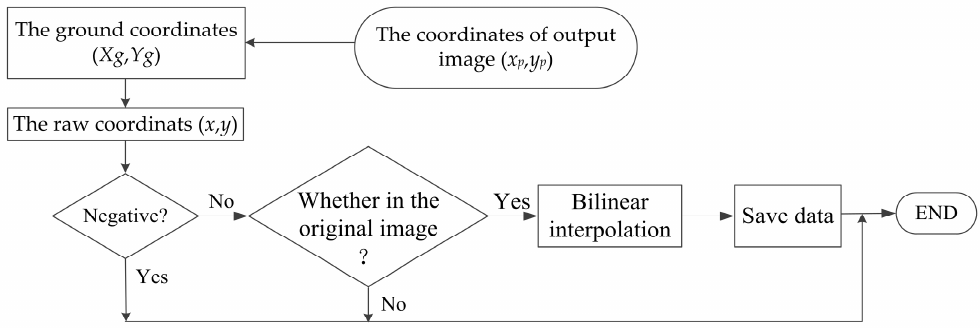
Figure 14. The flowchart of the coordinate transformation and bilinear interpolation.